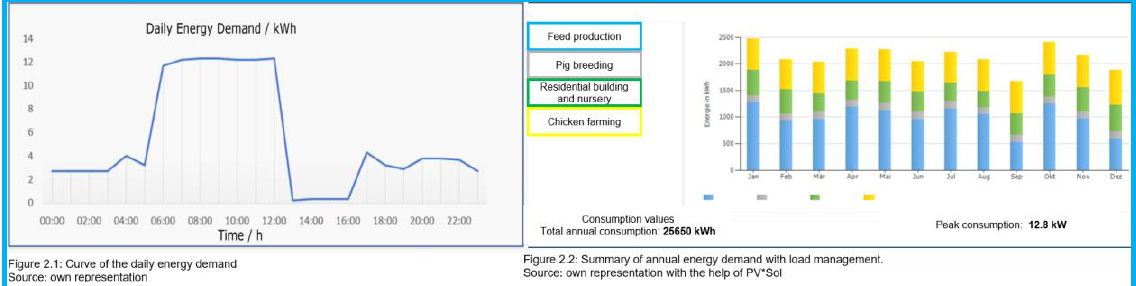
Figure 2 . Summary of daily and annual energy demand with load